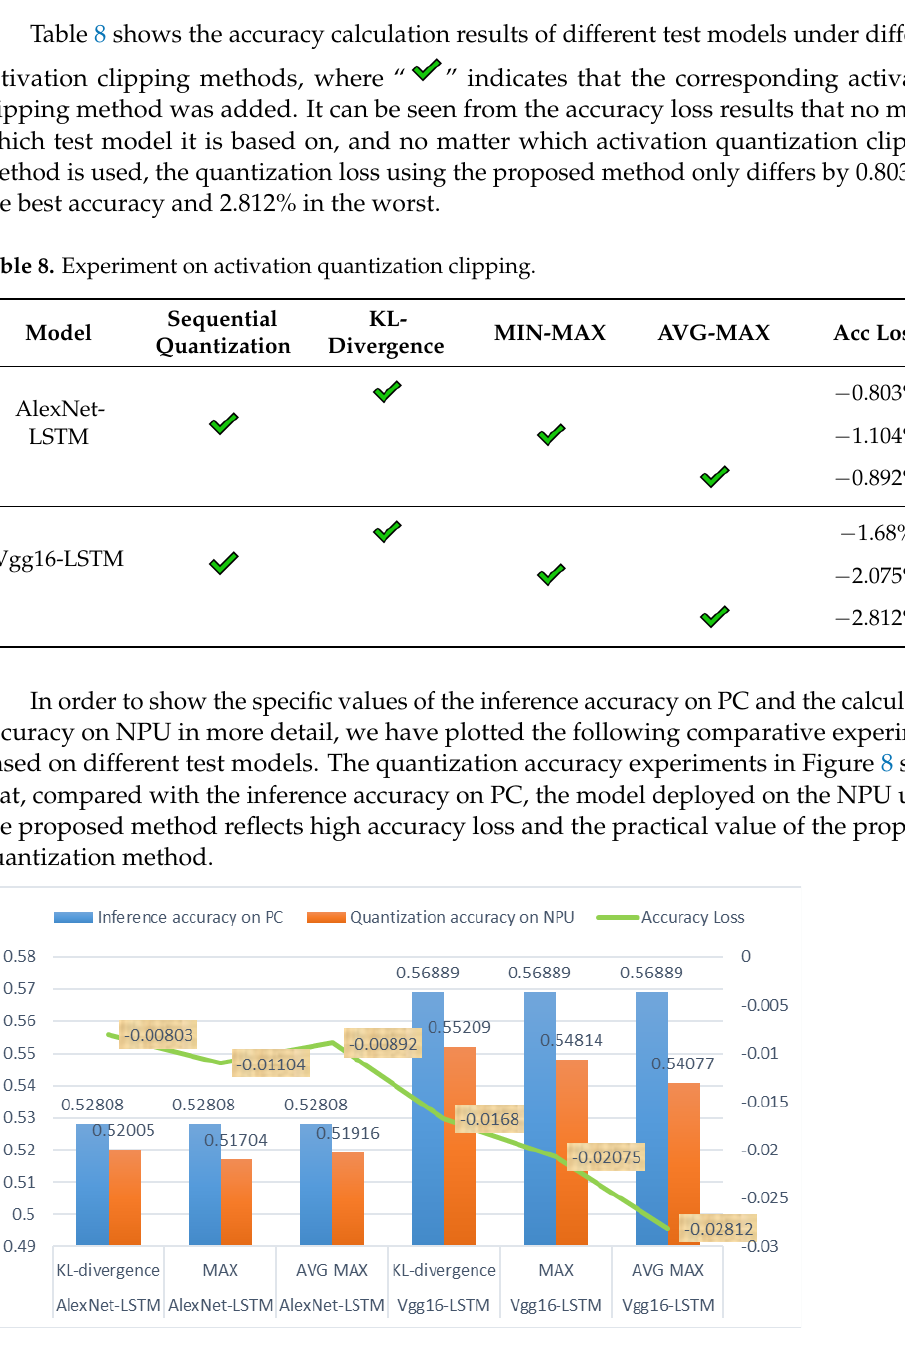
Figure 8. Detailed comparative experiment on different activation quantization clipping methods.